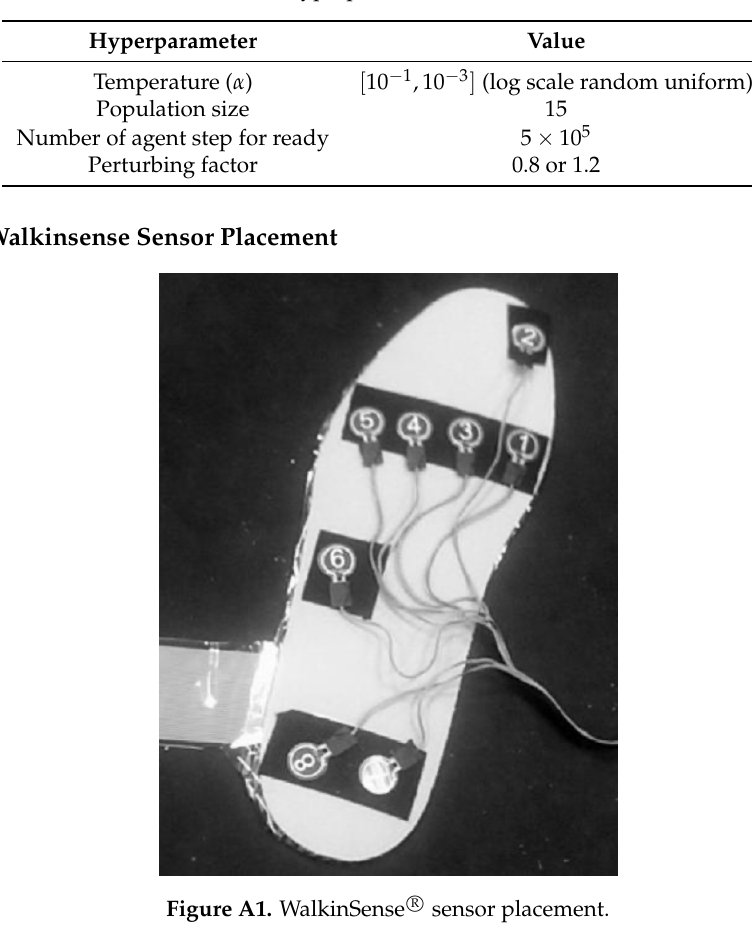
Table A2. Hyperparameters used for PBT.